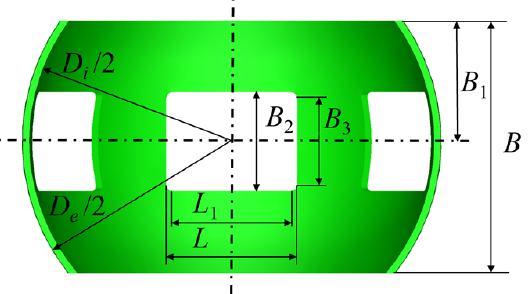
Figure 7. Structural parameter of ball cage.